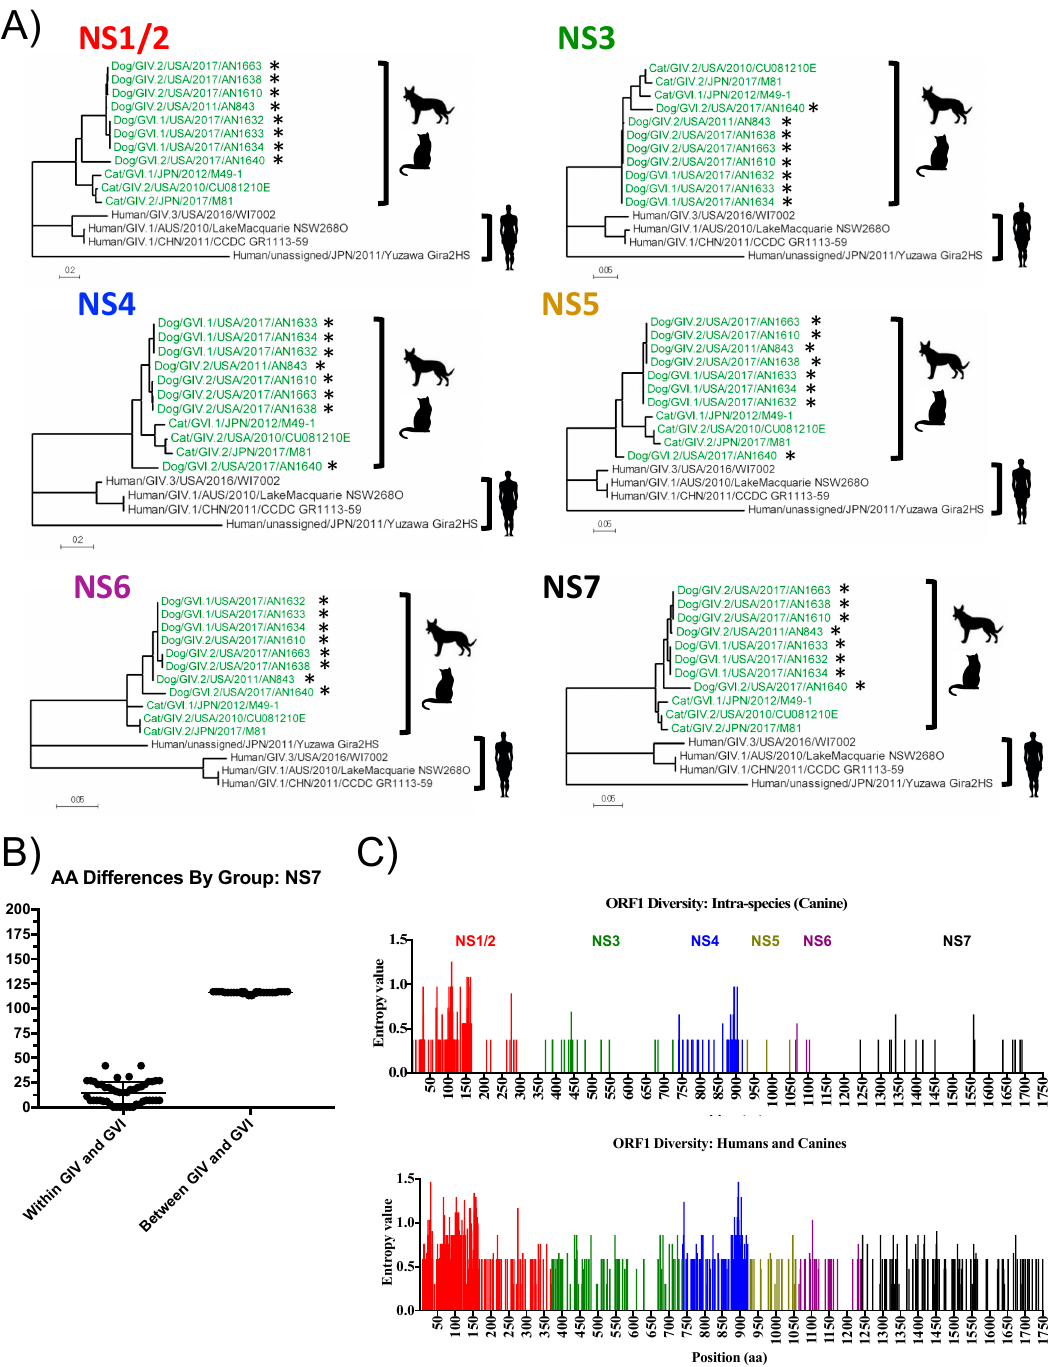
Figure 5. Analyses of GIV and GVI norovirus ORF1 reveal high diversity within regions of the non-structural proteins and the clustering into two distinct groups. ( A ) Maximum likelihood trees of the complete aa sequence of the individual non-structural proteins based on the Le Gascuel (2008) model. The phylogenetic trees were calculated with MEGA software (version 7.0.18). Strains described in this study are labeled with an asterisk (*). Strains highlighted in green and black represent animal and human noroviruses, respectively. ( B ) AA differences of the complete polymerase within and between groups (GIV and GVI). ( C ) Diversity plots, as calculated by Shannon entropy, spanning the ORF1 of canine noroviruses (intra-species, top panel) and canine and human noroviruses (inter-species, bottom panel). The values for each individual NS protein are differentiated by color.